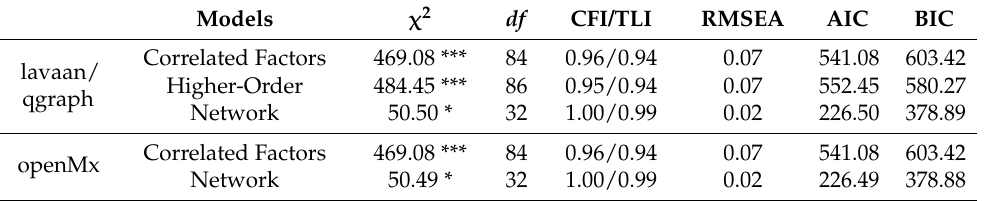
Table 5. Model fit for latent variable and network models of WAIS-IV correlations (middle group).